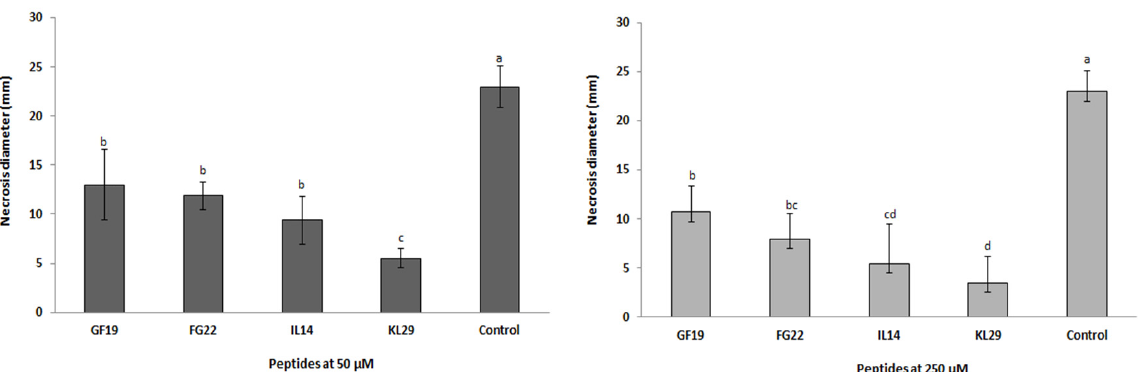
Figure 8. Effect of selected antimicrobial peptides on necrotic lesion diameter induced by Erwinia amylovora infection in immature pear fruits. The same letter indicates no statistical difference at p < 0.05. Error bars represent standard deviations of eight replications.